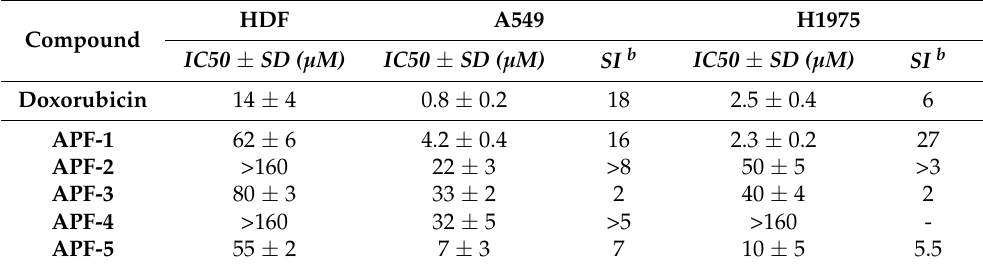
Table 2. Antiproliferative activity of tested compounds and related SI b obtained after 72 h of treatment by MTT assay in lung cancer and non-malignant cells a .